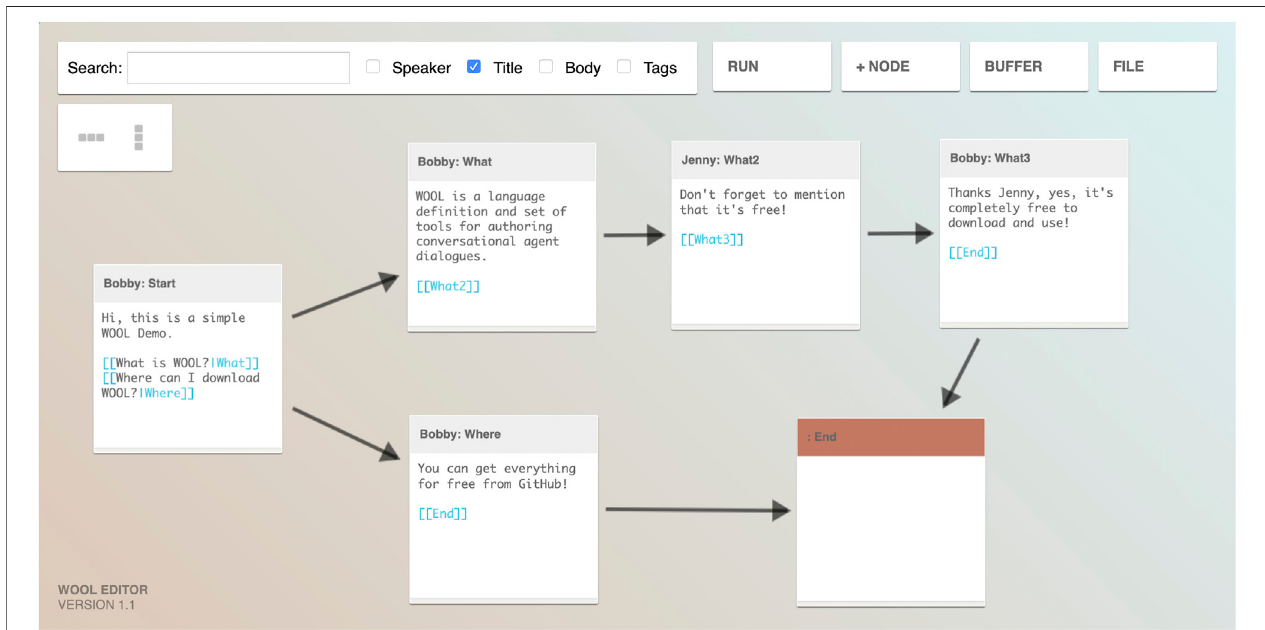
FIGURE5| TheWOOLvisualdialogueeditorshowingasimpleexampleofhowdialoguestepsmaybewrittenandlinkedtoeachother(takenwithpermissionfrom